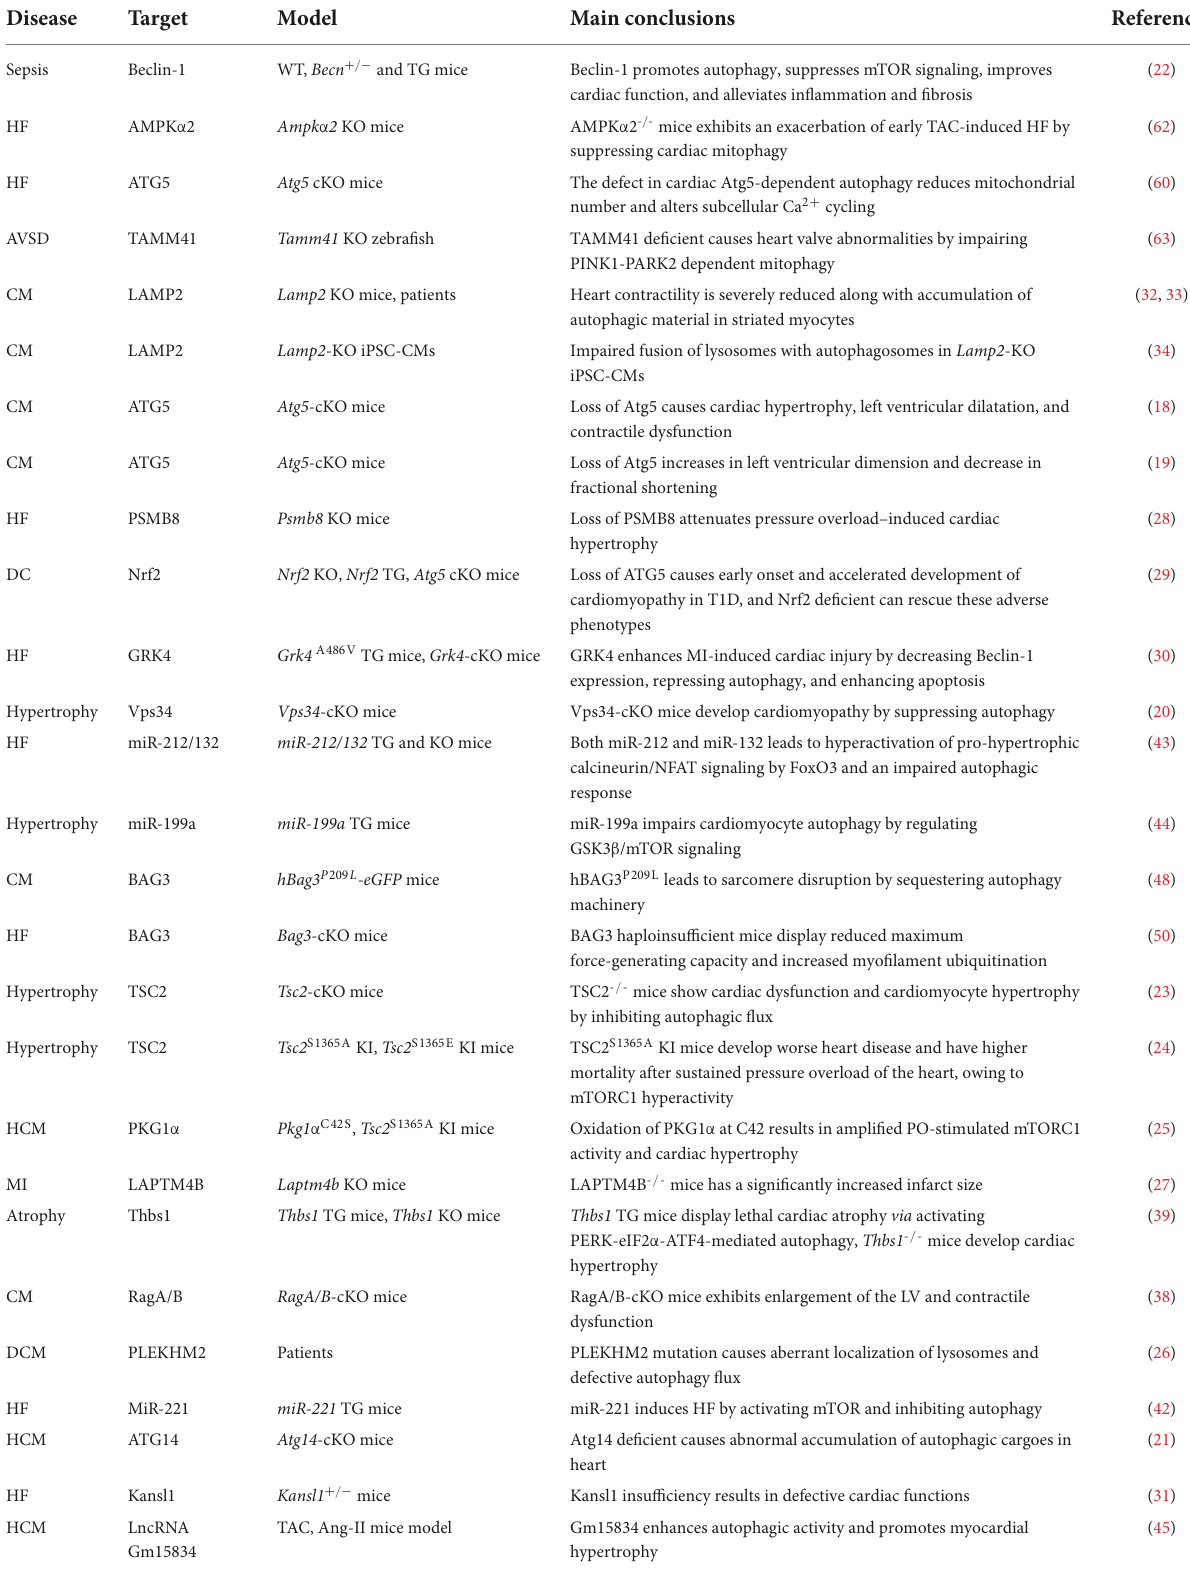
TABLE 1 Autophagy in heart diseases.